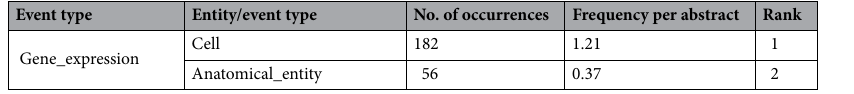
Table 6. Frequently observed entity and event types as arguments for each event type. Molecular entities are presented in italic and bold, whereas molecular events are shown in